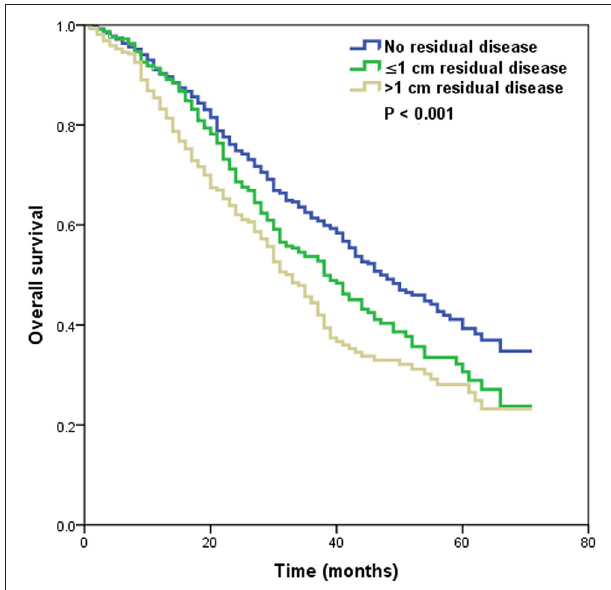
FIGURE 2 | Overall survival by the size of the residual tumor.